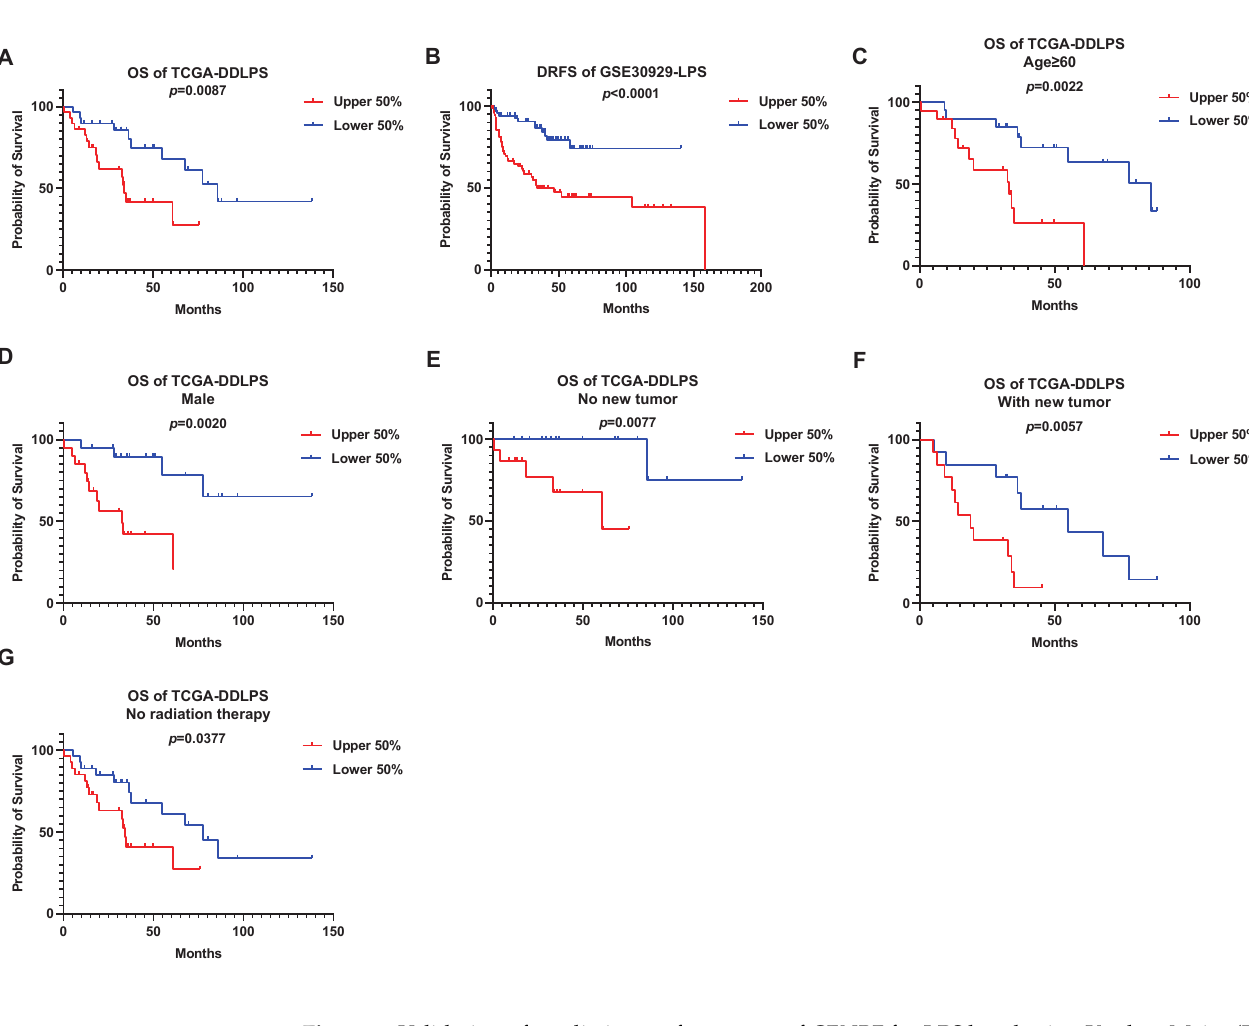
Figure 3. Validation of predictive performances of CENPF for LPS by plotting Kaplan–Meier (KM) curves. ( A ) KM curves of OS for DDLPS patients classified by CENPF expression (data derived from TCGA dataset). ( B ) Impacts of CENPF expression on DRFS. Survival curves based on CENPF expression of patients suffering from LPS (data derived from GSE30929 dataset). Verification of prognostic ability of CENPF for DDLPS patients classified by different clinicopathological features: ( C ) age: ≥ 60; ( D ) gender: male; ( E , F ) new tumor event after initial treatment; ( G ) radiation ther- apy. LPS: liposarcoma; DDLPS: dedifferentiated liposarcoma; OS: overall survival; DRFS: distant recurrence-free